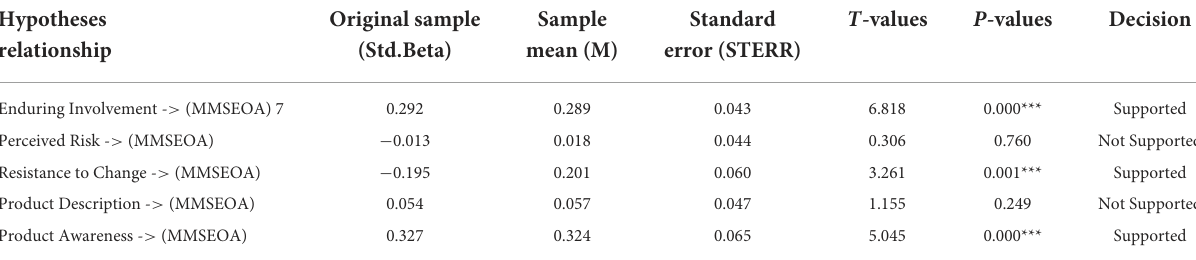
TABLE 6 Inner structural model results.